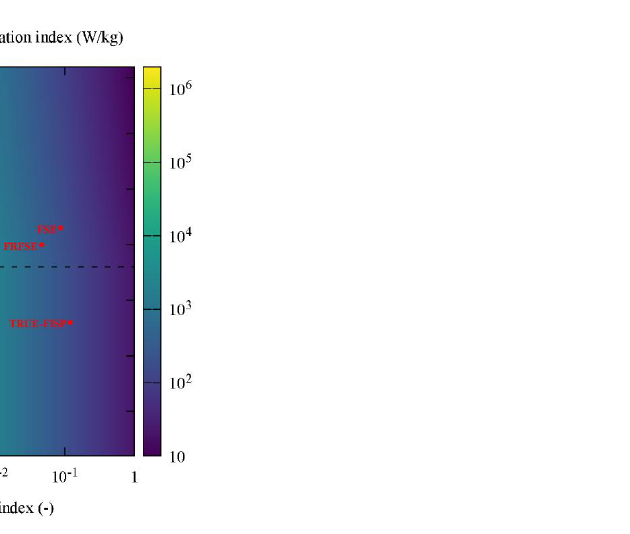
Figure 3. Chromatic map of maximum admissible configuration RF SAR index ξ TR , Max as a function of the RF stress index and of the sequence duration for hip and shoulder implants. The corresponding points in the ψ A - T seq plane of the used sequences are reported. The dashed line represents a sequence duration equal to T IEC /2. Below this value, ξ ∗ becomes independent of the sequence duration. 10g, S